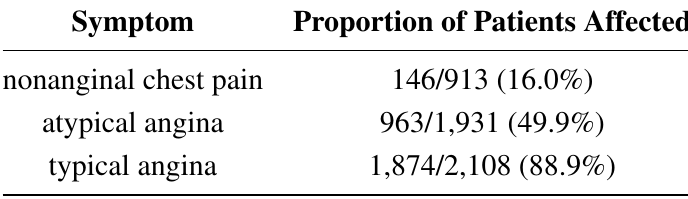
Table 4. Prevalence of CAD in symptomatic